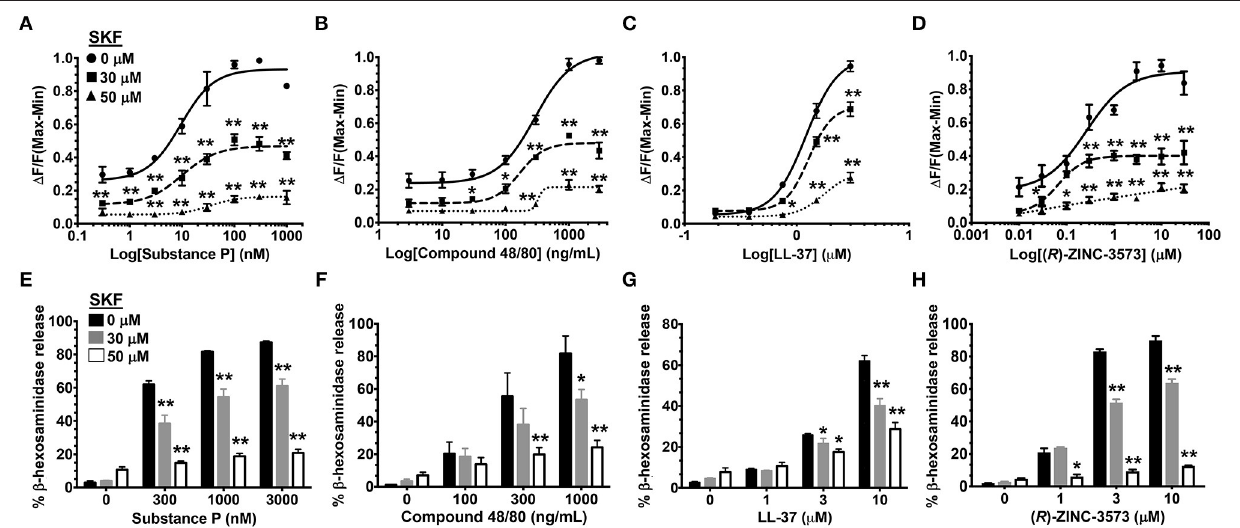
FIGURE 3 | SOCE inhibition attenuates mast cell Ca 2 + mobilization and degranulation to different MRGPRX2 agonists. LAD2 cells were treated with indicated concentrations of SKF, and Ca 2 + mobilization (A–D) and degranulation (E–H) assays were performed following incubation with substance P (A, E), compound 48/80 (B, F), LL-37 (C, G) and ( R )-ZINC-3573 (D, H) . Data shown are mean ± S.E. of three independent experiments. Statistical significance was determined by two-way ANOVA. * p < 0.05 and ** p < 0.01.